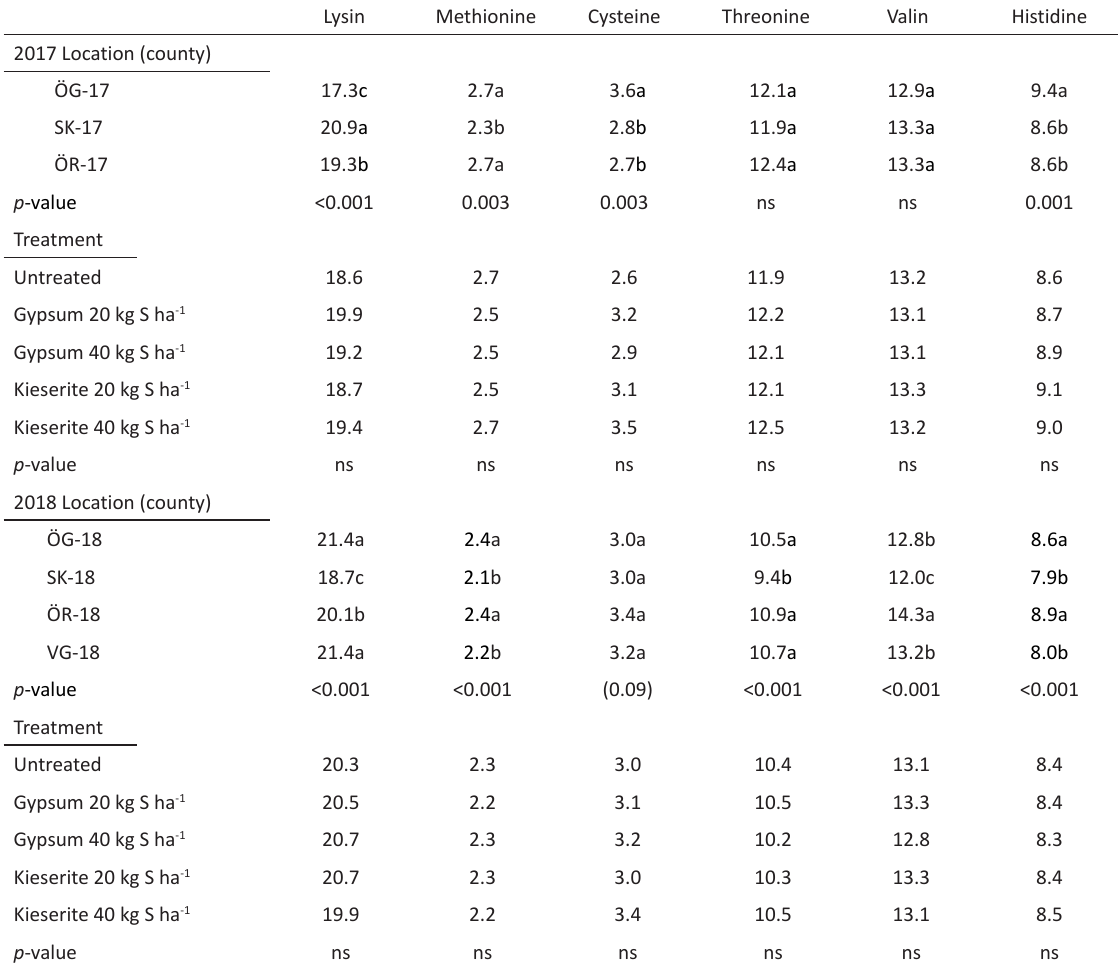
Table 8. Concentration of amino acids (g kg -1 DM) in faba bean treated with different products and various levels of sulphur applications at three field trial sites in 2017 and four field trial sites in 2018